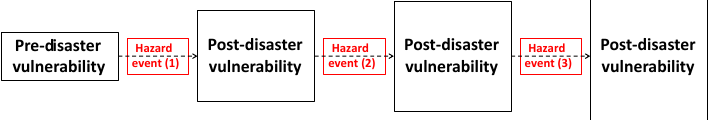
Figure 8. Example of vulnerability changes within a network of hazard interactions (cascade). A representation of changing vulnerability during a hazard cascade, where the magnitude of vulnerability is proportional to the size of the box. Following a disaster event, pressures on society, infrastructure and coping capacity are likely to be increased, and thus the vulnerability of a community and its systems/assets to further shocks or hazards may